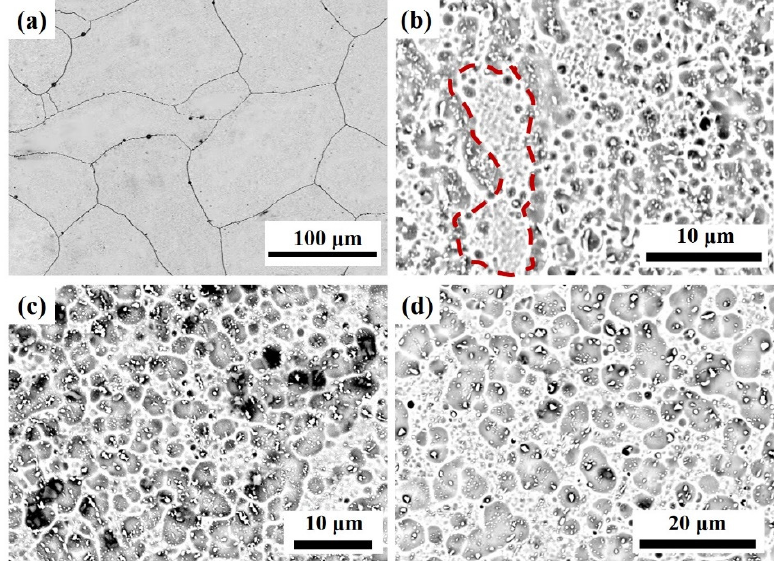
Figure 2. The SEM images of Fe 50 Mn 20 Cr 20 Ni 10 at different states: ( a ) homogenized, ( b ) annealed at 1073 K for 1 h, ( c ) annealed at 1173 K for 1 h, ( d ) annealed at 1273 K for 1 h.